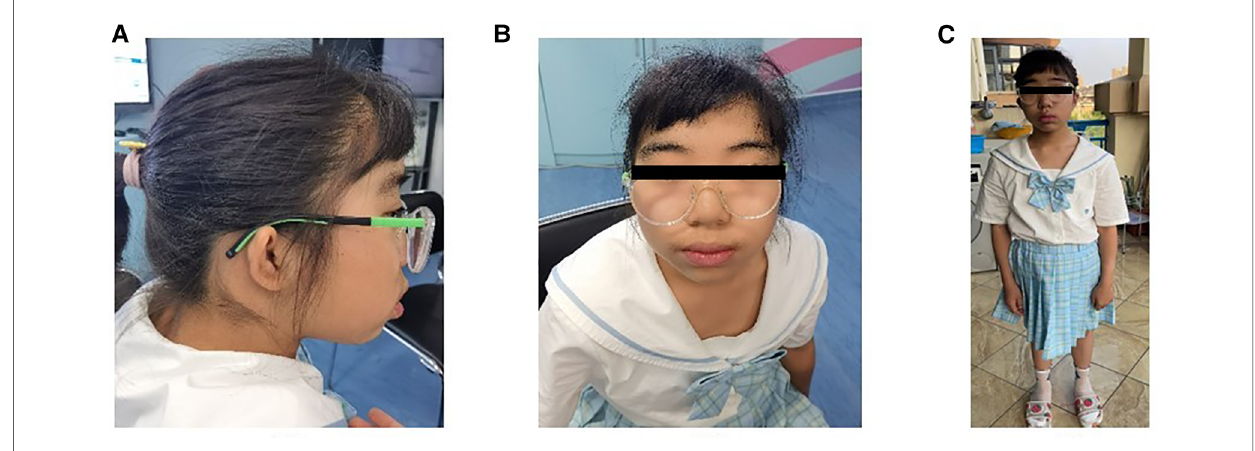
FIGURE 1 Proband aged 13 years and 6 months. ( A ) pro fi le ( B ) frontal ( C )